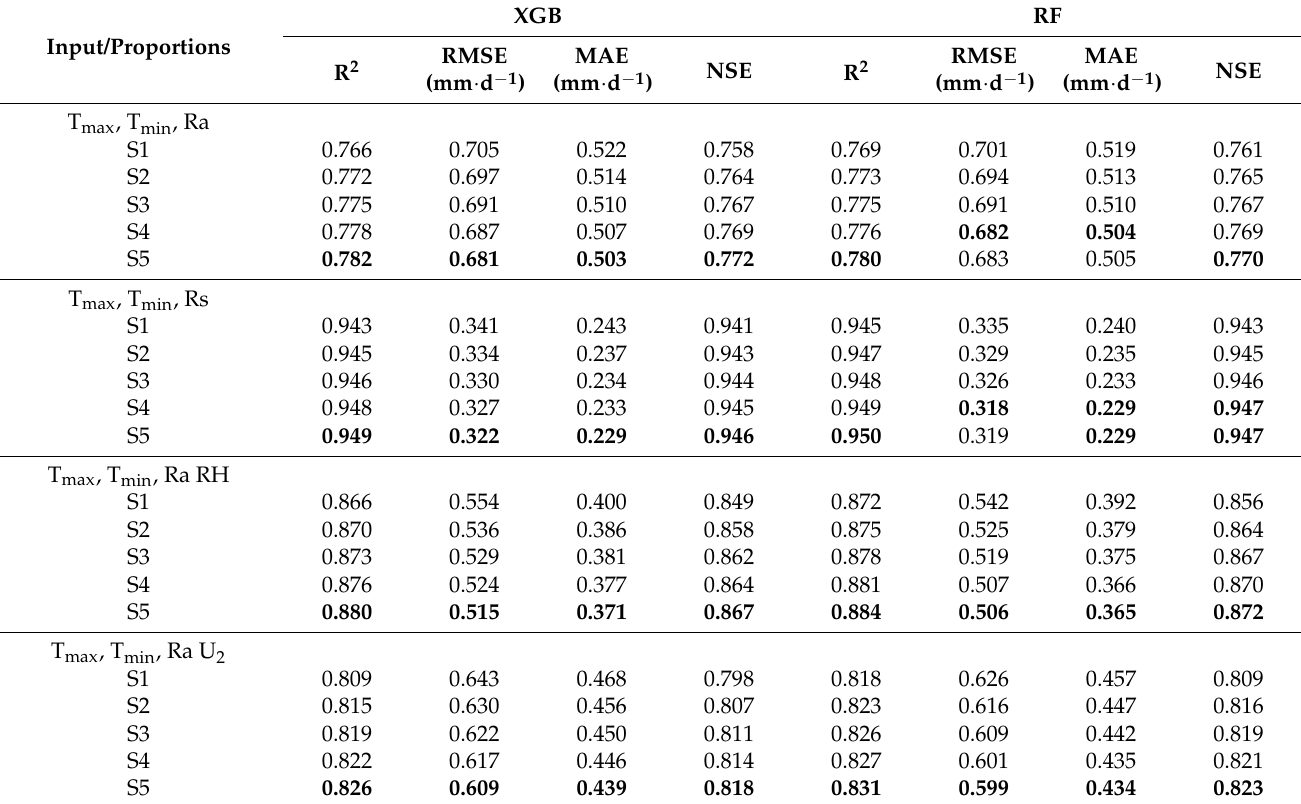
Table 6. Average statistical values of five proportions of different input parameters of two machine learning models in the testing process of 21 stations